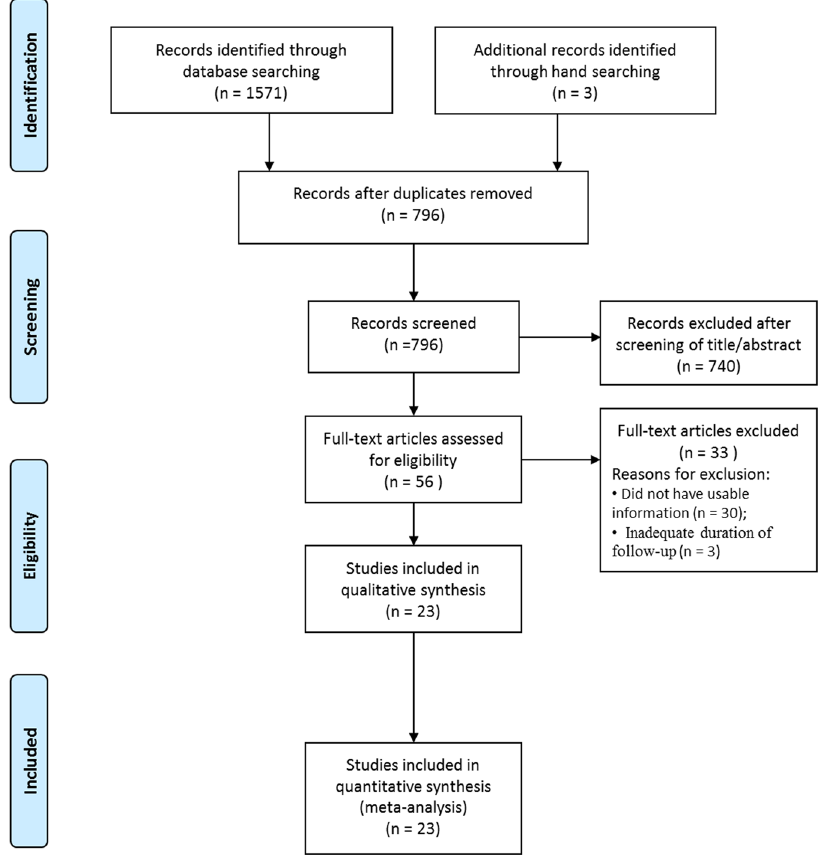
Figure 1. PRISMA (Preferred Reporting Items for Systematic reviews and Meta-analyses) flow diagram of the identification and selection of the studies included in this